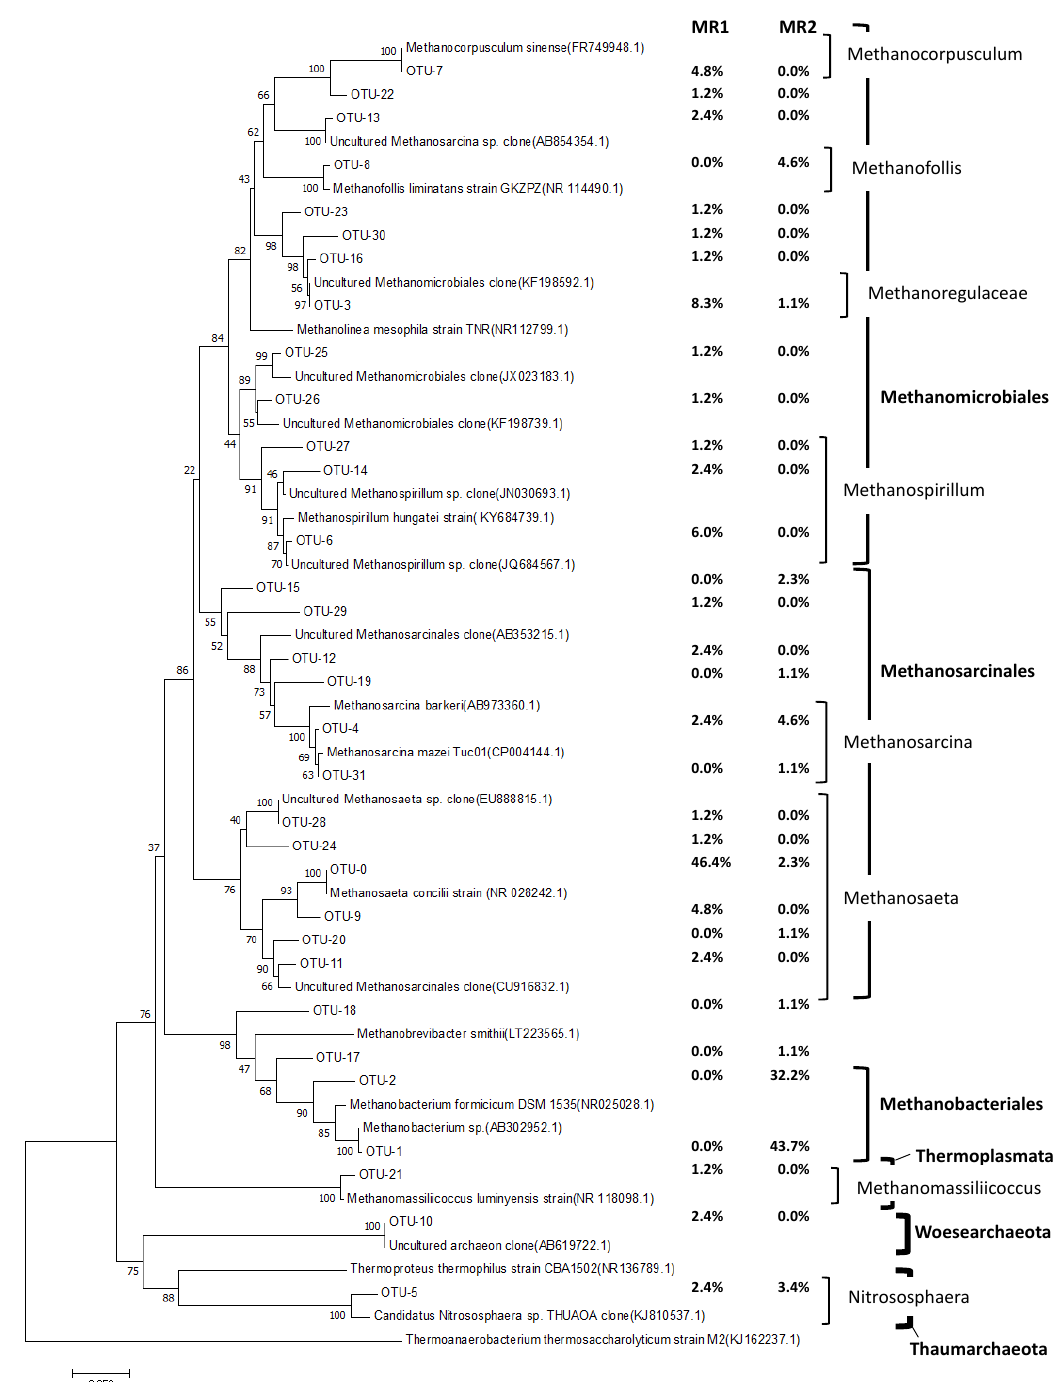
Figure 6. Phylogenetic tree of the Archaeal OTUs in the CH 4 -reactors in two-stage and single-stage anaerobic digestion (AD) system and their close relatives retrieved in GenBank database based on 16S rRNA gene sequences. The relative abundance of each OTU are shown on the right. Numbers at nodes represent bootstrap values. The scale bar represents 0.05 substitution per nucleotide position. The confidence thresholds of the taxonomic classification for most OTUs illustrated on the right were above 98%, whereas the confidence threshold for OTU-15, OTU-27 and OTU-28 affiliated with order Methanosarcinales, genus Methanospirillum and genus Methanosaeta were 86%, 94% and 92%,